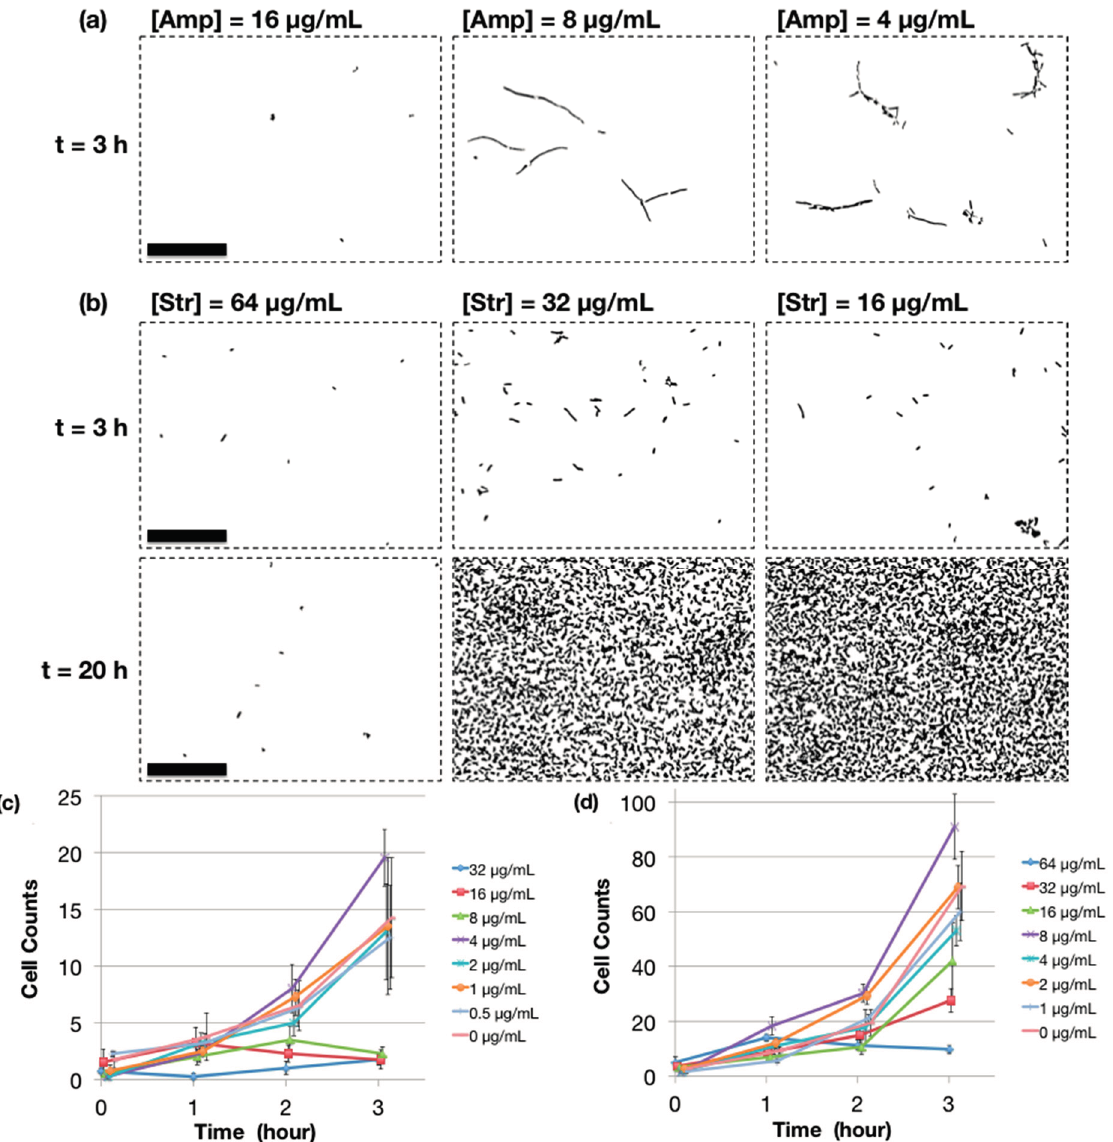
Figure 4. On-chip MIC determination based on antibiotic gradient generation. The images are selected to be representative of the cell growth pattern observed in the micro culture chamber and processed with the ImageJ software as detailed in the Experimental Section. ( a , c ) ampicillin (Amp)-treated E. coli cells and ( b , d ) streptomycin (Str)-treated E. coli . The average cell counts (in the 100 μ m × 75 μ m region of interests) were calculated to determine the breakpoints for MIC, which are 5 cells and 16 cells for Amp and Str, respectively.